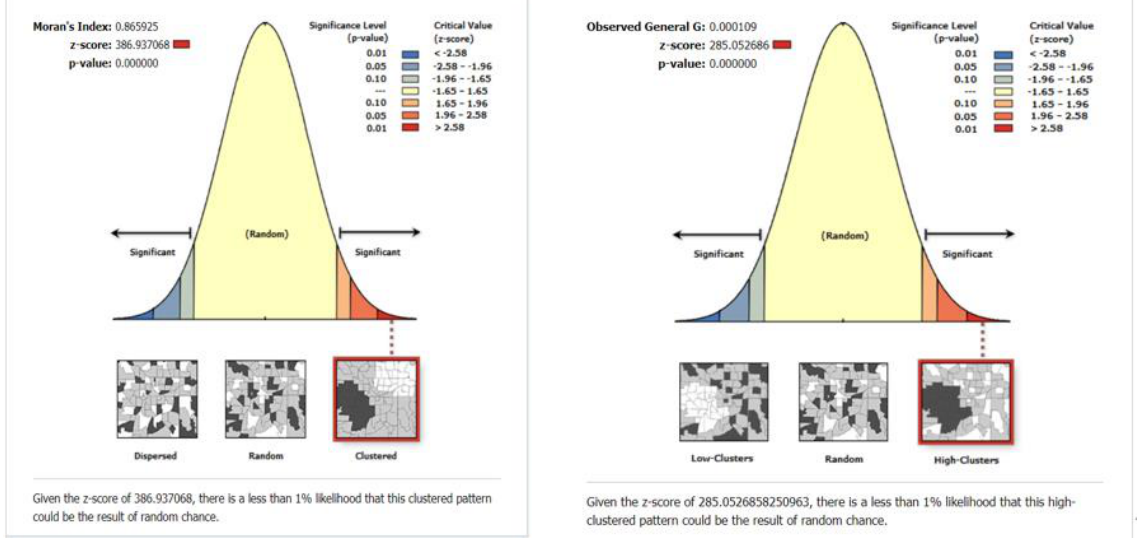
Figure 8. Global Moran ’ s I (Category- Ⅱ ); Getis – Ord General G (Category- Ⅱ ).